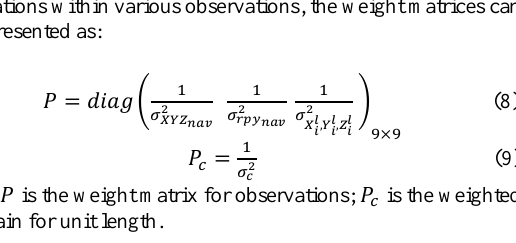
Table 1. Performance characteristics of C-MIGITS and